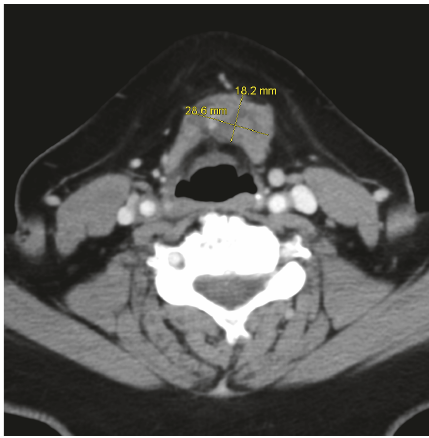
Figure 1: Transverse view of the CT neck that showed presence of a neck mass measuring 28.6 mm × 18.2 mm.